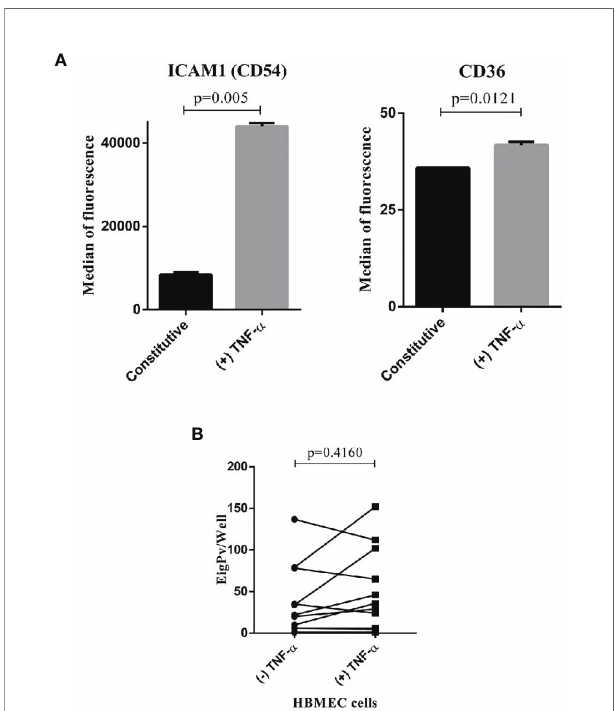
FIGURE 1 | Plasmodium vivax gametocytes adhesion to HBMEC. (A) Expression of ICAM1 and CD36 in HBMEC cell with or without stimulation of TNF-alpha. The cells were incubated with TNF-alpha (10 ng/mL) for 18h stimulated the expression of endothelial cells markers ICAM1 and CD36. The expression was determinate for FACS and expressed as the median of fl uorescence. The data were analyzed by Unpaired t test. (B) Cytoadhesion assays of P. vivax gametocytes to bone marrow endothelial cells (HBMEC) with or without stimulation of TNF- a . The cytoadhesion was expressed as the total number of gPv-pRBC adhered to HBMEC cells per slide well. The data are shown as the mean ± standard deviation from a total of 13 biological replicates (isolates). The data were analyzed by Wilcoxon Rank